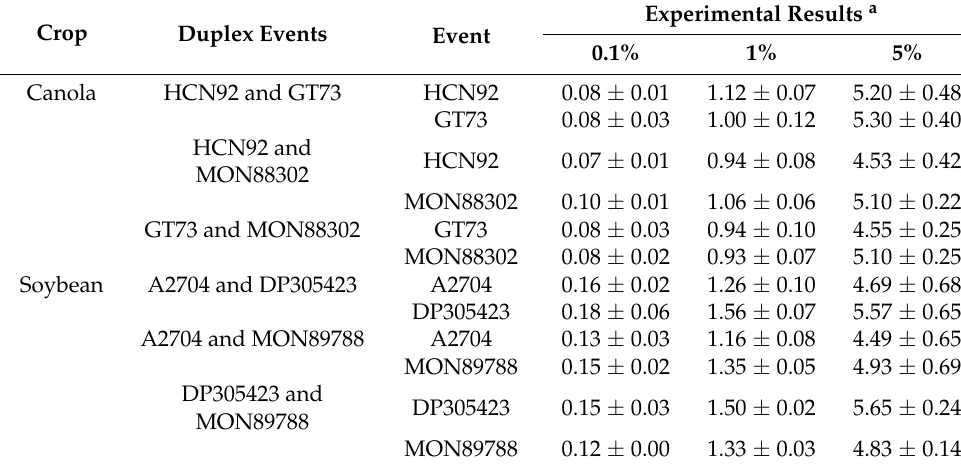
Table 2. Experimental results for duplex ddPCR assays for GM canola and soybean events. Crop